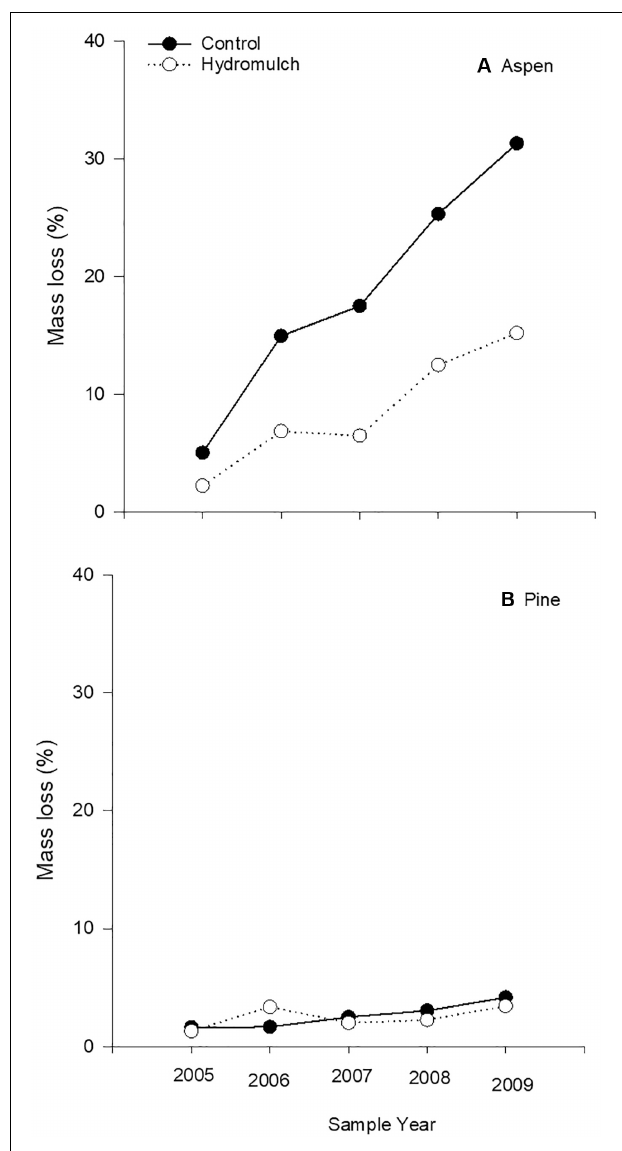
FIGURE 3 | Mass loss of (A) aspen and (B) pine surface stakes from microbial decay following a hydromulch application after the Cedar Fire near Alpine,